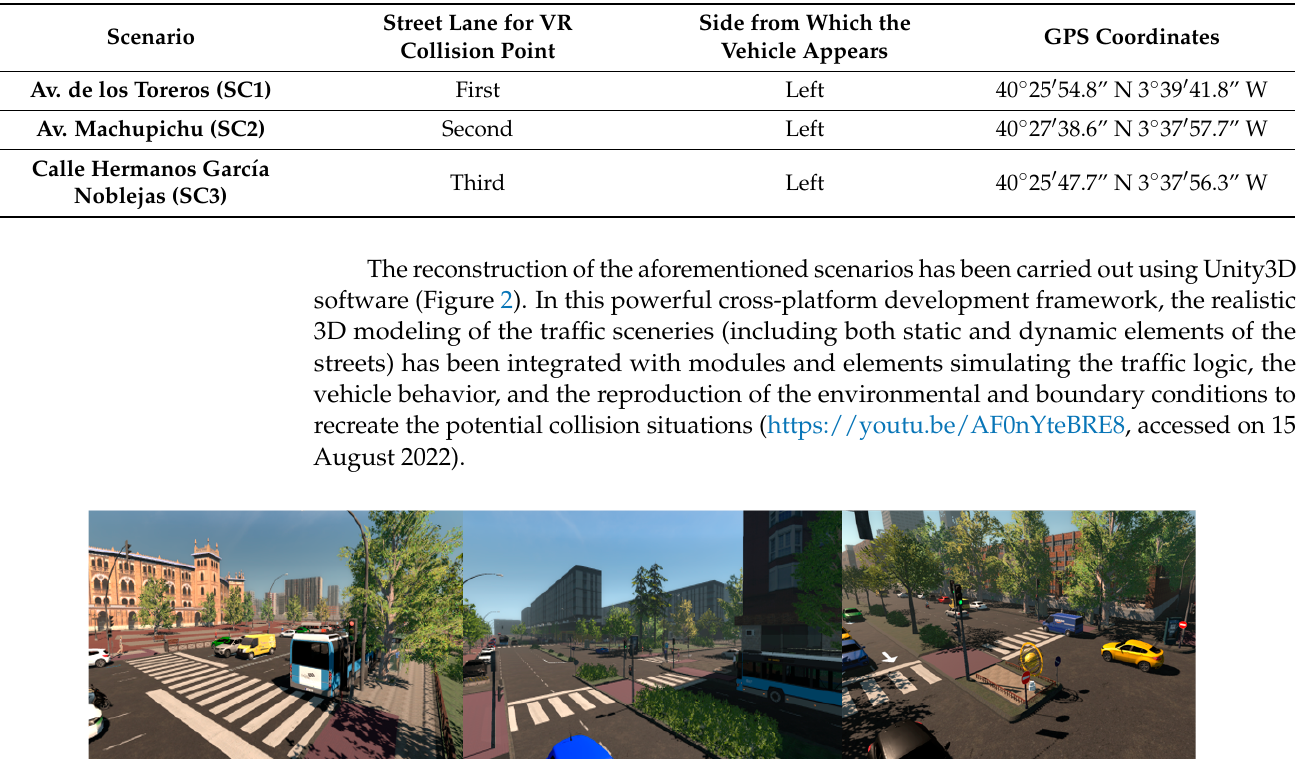
Table 1. Scenarios modeled in VR for the experimental session.